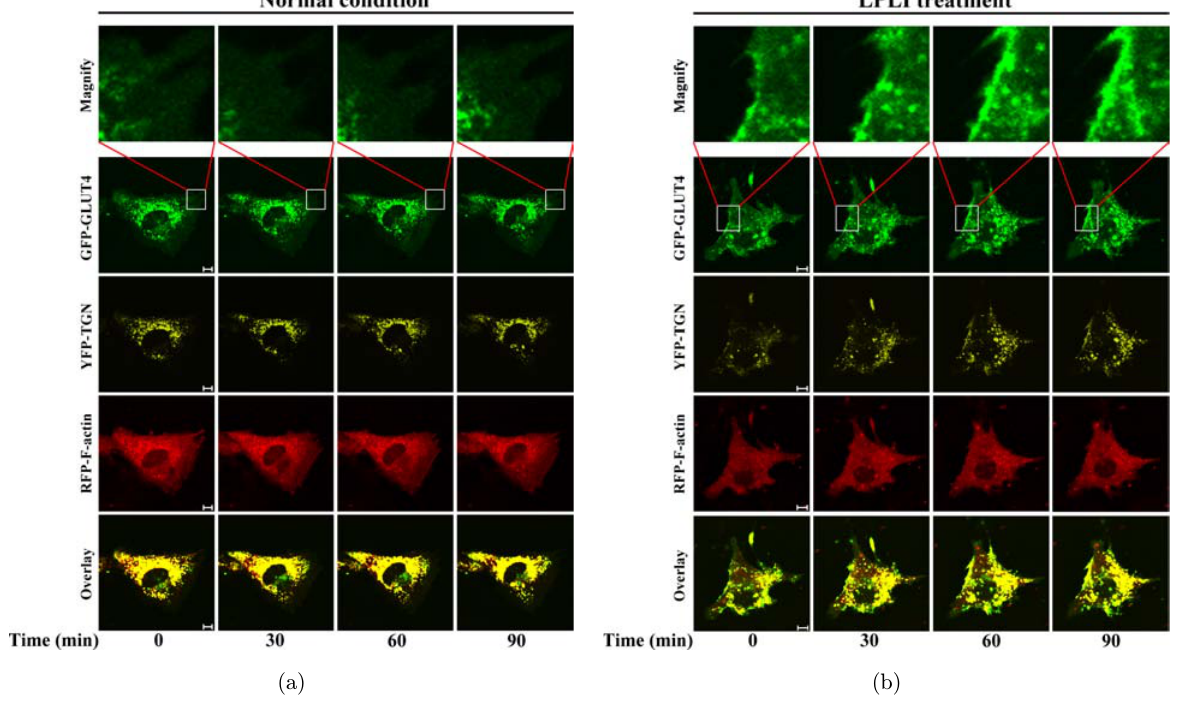
Fig. 2. Real-time monitorings of the dynamic changes of GLUT4 in single living cell. 3T3-L1 adipocytes were co-transfected with GFP-GLUT4, YFP-TGN38 and RFP-F-actin expression plasmids. About 48 h later, the cells were serum-starved for 6 h and then treated with or without LPLI (5 J/cm 2 Þ and the dynamic changes of GLUT4 was observed with confocal microscopy. (a) The time- elapse of the dynamic changes of GLUT4 in 3T3-L1 adipocytes without any treatment (n ¼ 3). Bar ¼ 10 (cid:4) m. (b) The time-elapse of the dynamic changes of GLUT4 in 3T3-L1 adipocytes treated with LPLI (5J/cm 2 Þ ( n ¼ 3). Bar ¼ 10 (cid:4) m. (c) Western blot analysis of GLUT4 expression in cytosol and cytomembrane under LPLI (5 J/cm 2 Þ treatment ( n ¼ 3). (d) Quantitative analysis of the changes of GLUT4 expression. Data represent mean (cid:3) SEM ( n ¼ 3, * p < 0 : 05 versus control